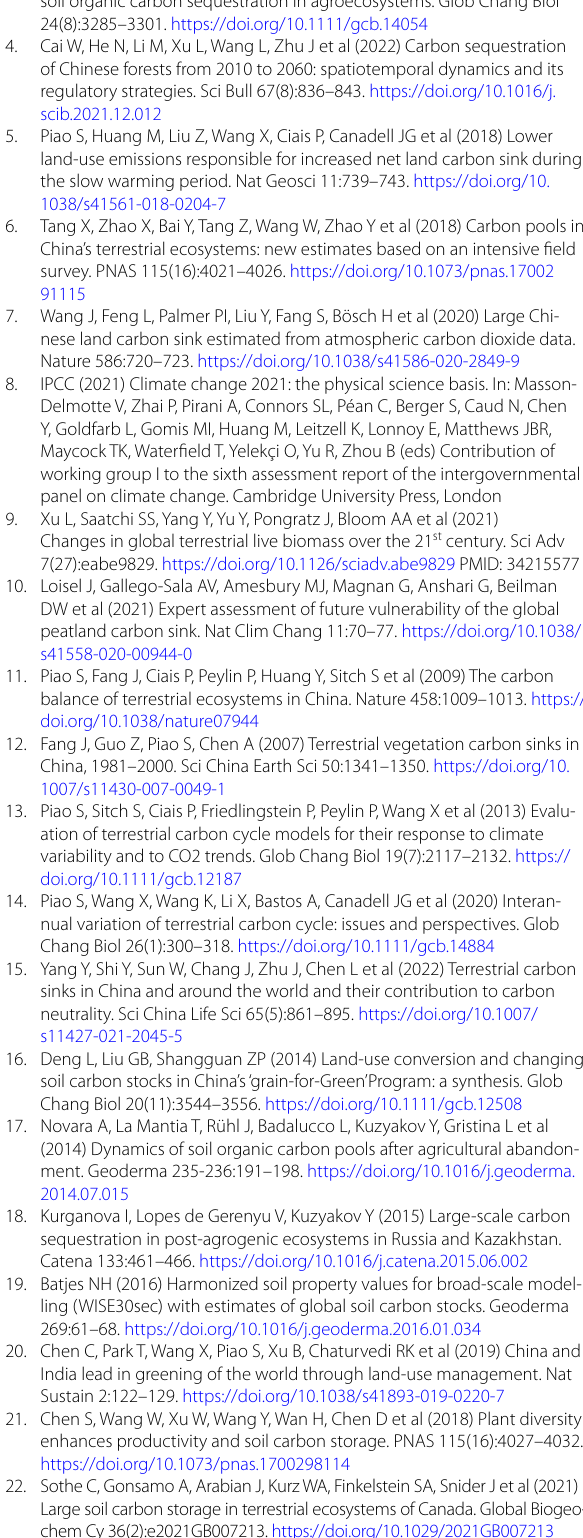
Additional file 2: Table S1. The plant types of the study sites across the Loess Plateau. Table S2. The precision of the model of kriging interpola- tion for ecosystem C stocks. Table S3. The precision of the random forest model for ecosystem C stocks. Table S4. Summary of soil properties about ecosystems across the Loss Plateau of China. Table S5. Geostatistical parameters for soil factors across the Loess Plateau. Table S6. Geosta- tistical parameters for soil organic carbon (0–10 cm and 10–20 cm) and ecosystem carbon density across the Loess